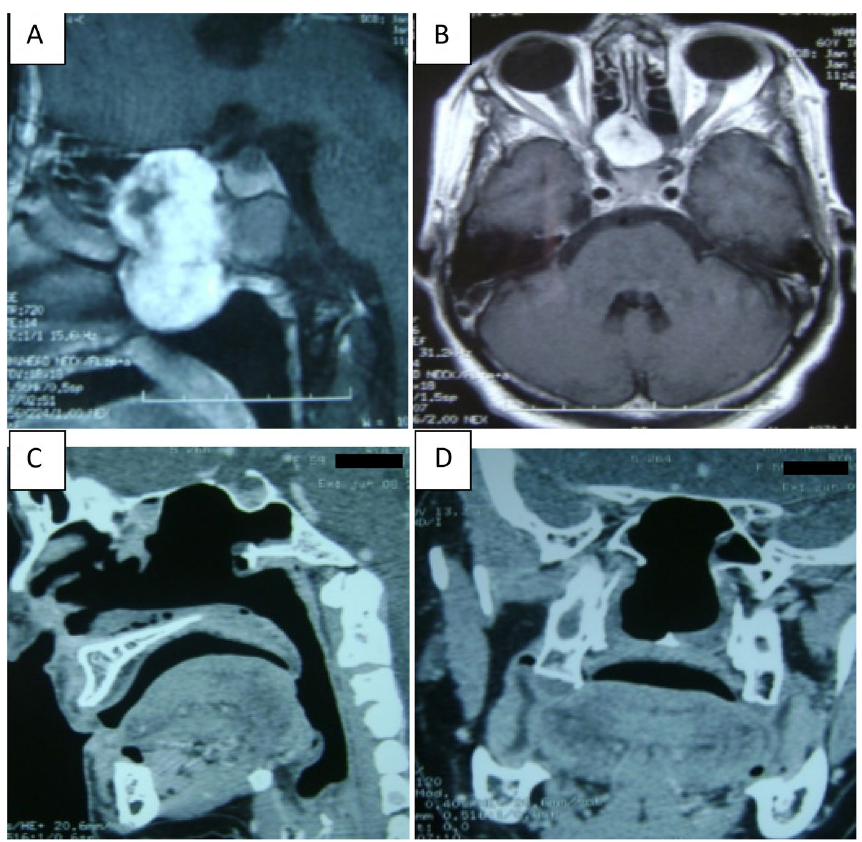
Fig. 3 Case 3. Sphenoid sinus chondroma. MRI sagittal view ( A upper left) showing a tumor of the sphenoid sinus expanded to the rhinopharynx with no intracranial involvement. On MRI axial view ( B upper right), the tumor does not involve surrounding structures. Postoperative CT scan sagittal view ( C lower left) and coronal view ( D lower right) showing a total removal of the sphenoid sinus tumor